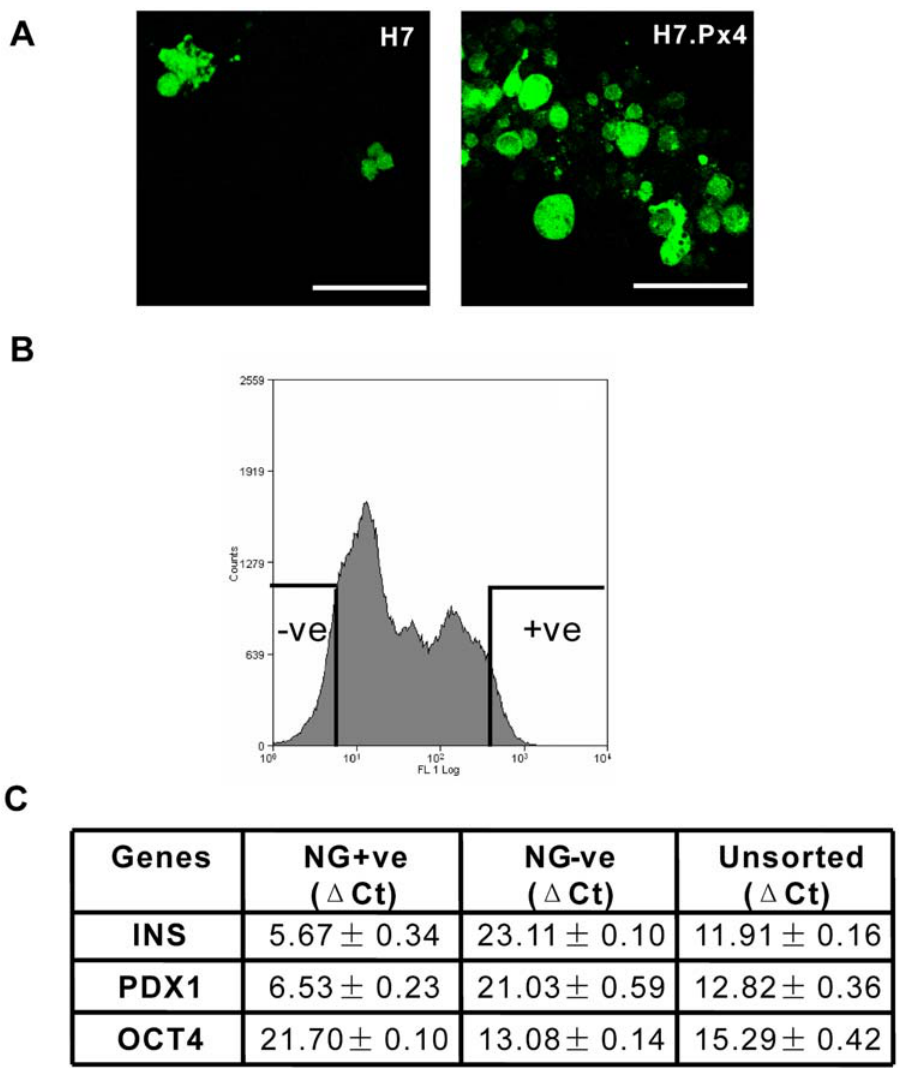
Figure 4. Isolation of putative b -cells based on high zinc content using a vital dye, Newport Green (NG). (A) Confocal microscopic examination of NG staining in H7 and H7.Px4 EB-derived cells. Note the quasi-homogeneous fluorescence of NG-labeled zinc-positive cells with cytoplasmic dots. (B) Isolation of NG + ve (top 10%) and NG-ve (bottom 10%) H7.Px4 cells by FACS. The selected cells were collected and analyzed by Q-PCR for the expression of Ins , Pdx1 and Oct4 . (C) Gene expression levels in the sorted NG + ve, NG-ve and the unsorted cells are represented as D Ct values ( 6 standard deviation) relative to ACTB for all samples. Note that an increase in D Ct of 1.0 represents 2-fold decrease in mRNA level. The D Ct value was determined by subtracting the average housekeeping ( ACTB ) Ct value from the average target genes ( Pdx1 , Ins and Oct4 ) Ct values. Error bars represent the standard deviation of the difference, as calculated from the standard deviation of the target and ACTB values.